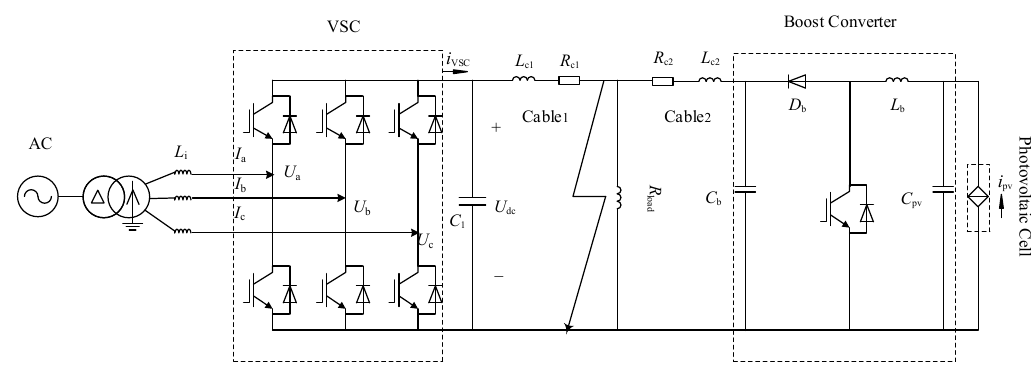
Figure 2. Structure of a LVDC distribution network.